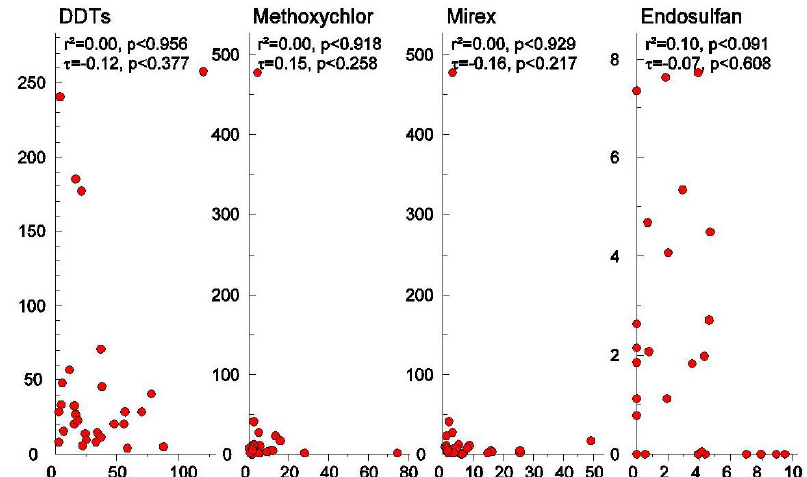
Figure 3. Concentration of individual OCPs (HCHs, HCB, drins, CHLs) between rice ( Y -axis) and soil ( X -axis) in Thailand and China.